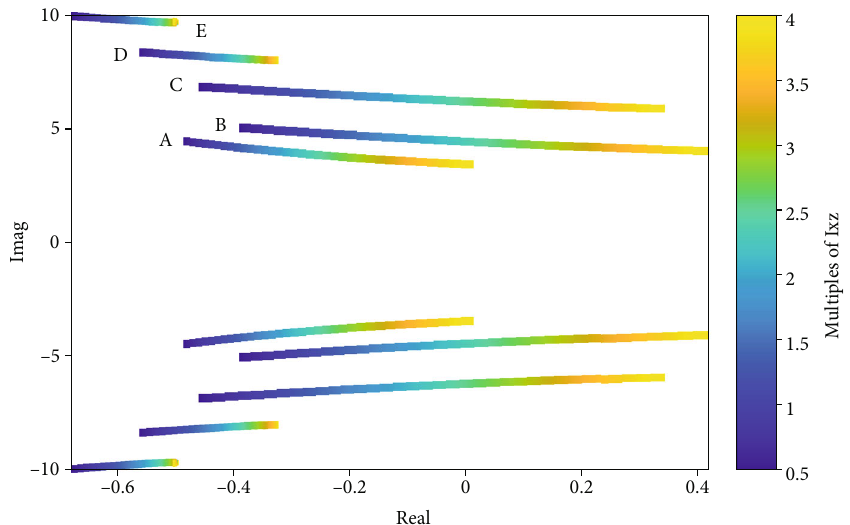
and various Mach numbers (A: Ma = 0 : 6 ; B: Ma = 0 : 8 ; C: Ma = 1 : 0 ; D: Ma = 1 : 2 ; xz